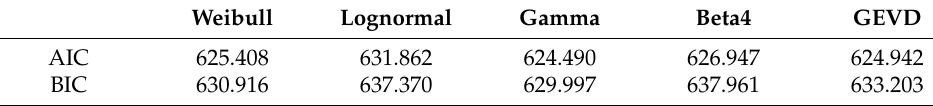
Figure 6. Scatter plot of average wind speed versus mean ozone. Table 2. AIC and BIC criteria for average wind.